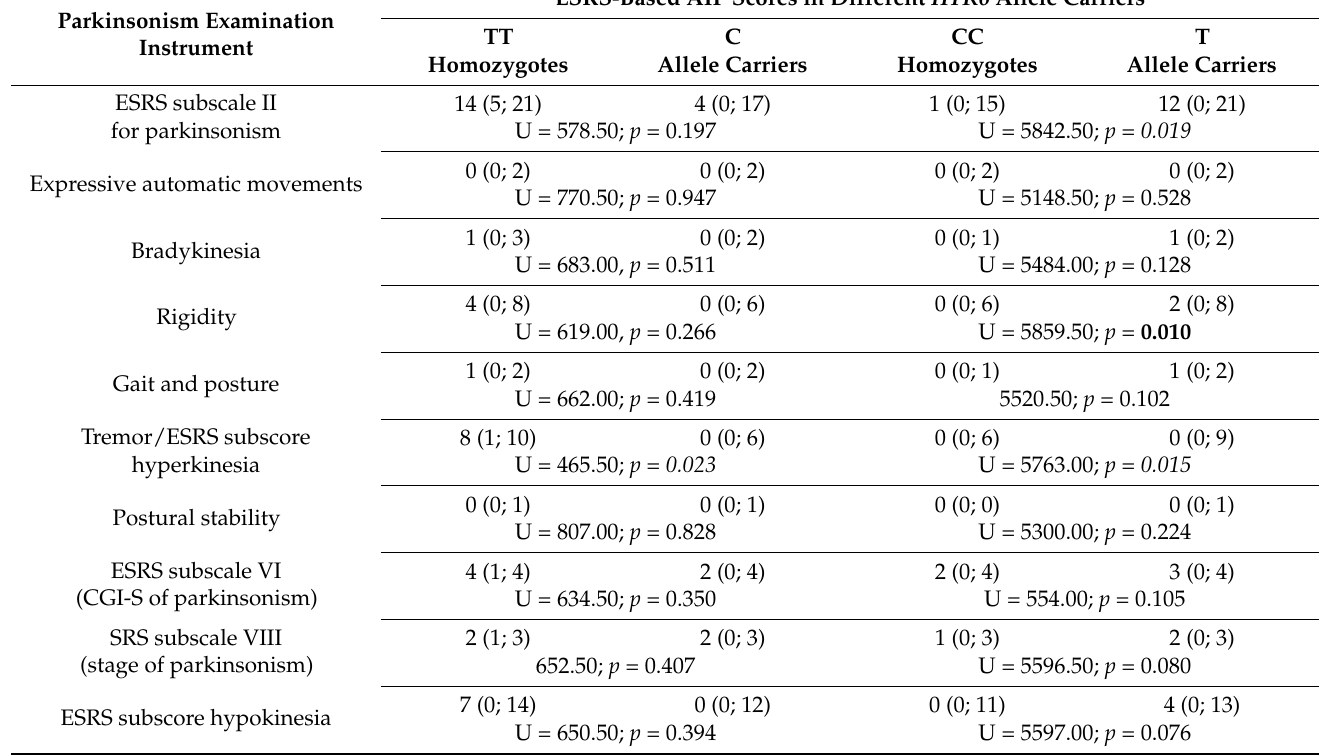
Table 3. ESRS-based AIP scores in haloperidol-treated schizophrenia patients with different HTR6 rs1805054 alleles.